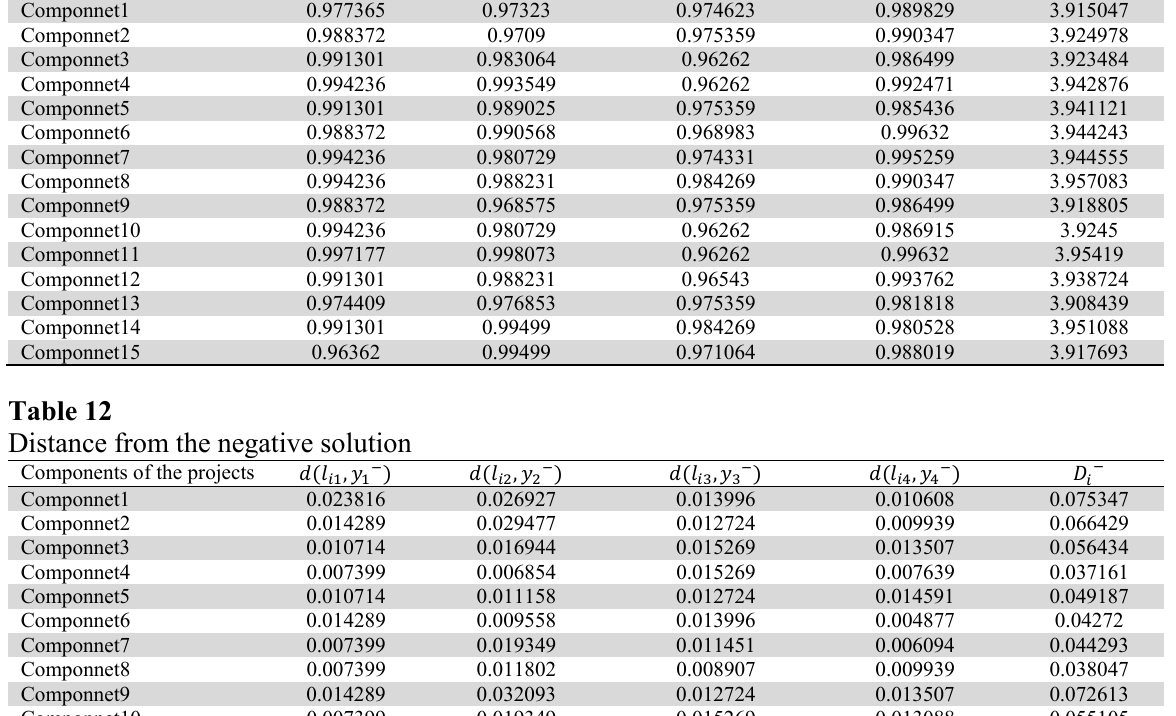
Distance from the positive solution Components of the projects